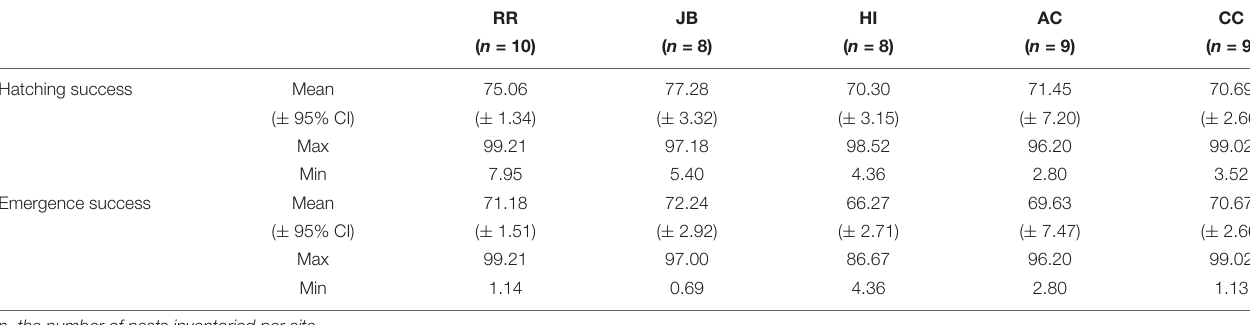
TABLE 2 | Descriptive statistics for hatching and emergence success at each nesting beach during the 2020 study period. RR JB